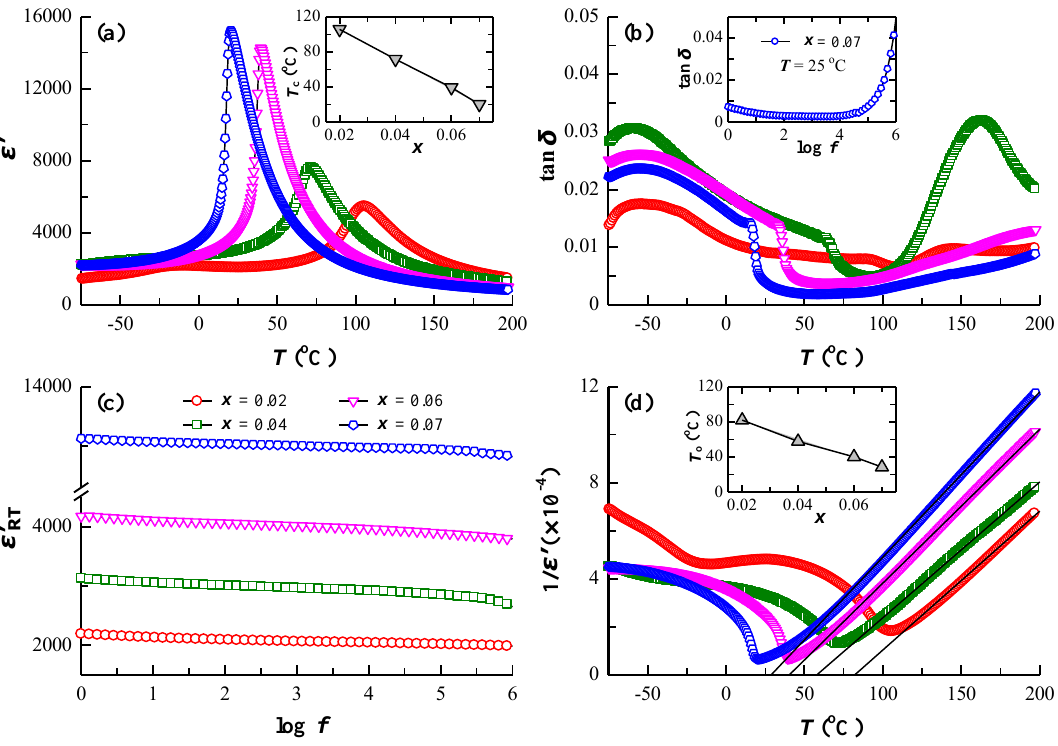
Figure 8. ( a ) Dielectric permittivity ( ε (cid:48) ) and ( b ) dielectric loss (tan δ ) as functions of temperature for BSTM ceramics. The insets depict T c versus x and frequency dependence of room temperature tan δ for the x = 0.07 sample; ( c ) variation of room temperature permittivity ( ε (cid:48) RT ) as a function of frequency for BSTM ceramics; ( d ) curves of 1/ ε (cid:48) versus temperature at 1 kHz (symbols, experimental data; solid line, fitting to the Curie–Weiss law). The inset depicts T 0 versus x . Furthermore, the dielectric properties of a normal ferroelectric material meet the Curie – Weiss law described by the equation as below: